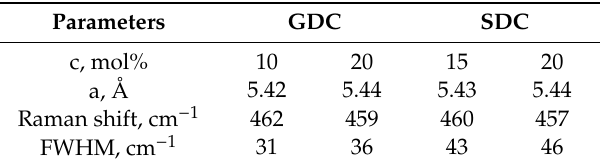
Table 3. Change of the F2g mode peak position and FWHM with respect to dopant concentration and lattice constant GDC10, GDC20, SDC15, and SDC20 thin